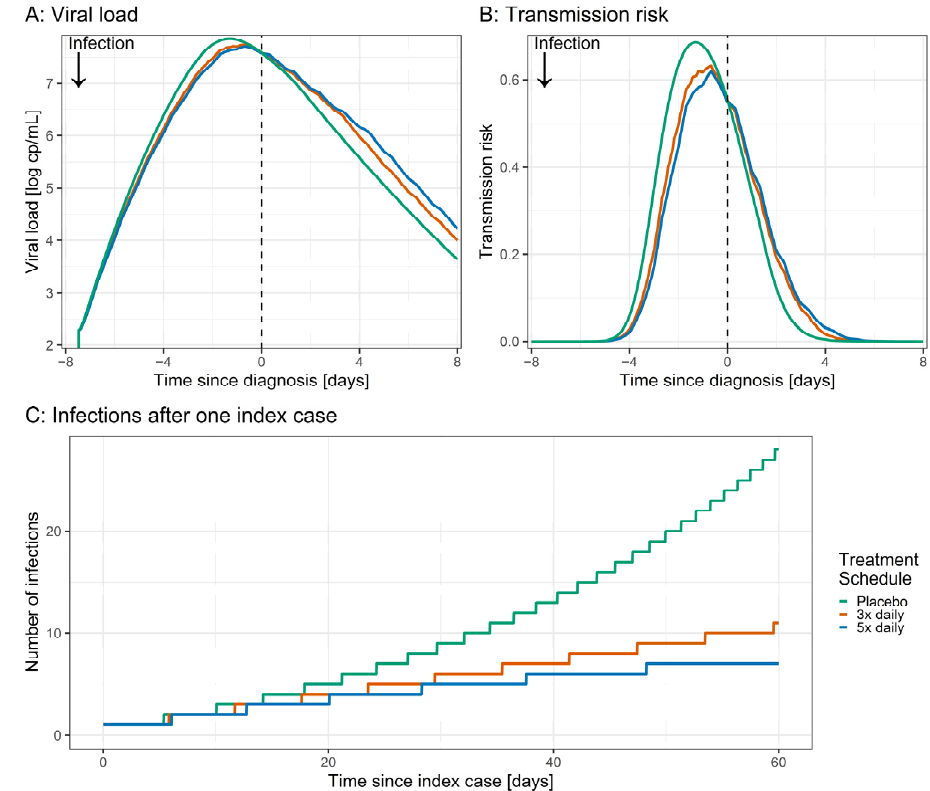
Figure 5. Scenario simulations of SARS-CoV-2 viral load ( A ), transmission risk ( B ) and subsequent infections ( C ) after placebo (green) vs. preventive administration of 3 × 0.1% azelastine (red), 5 × 0.1% azelastine (blue). Simulated preventive treatment started 11 days before infection and was continued until the end of simulations. ( A ) Viral load after infection with SARS-CoV-2. ( B ) Transmission risk associated with the respective viral load. ( C ) Number of infections resulting from the detection of one index case assuming modest contact restriction measures (baseline placebo R(t) = 1.2).